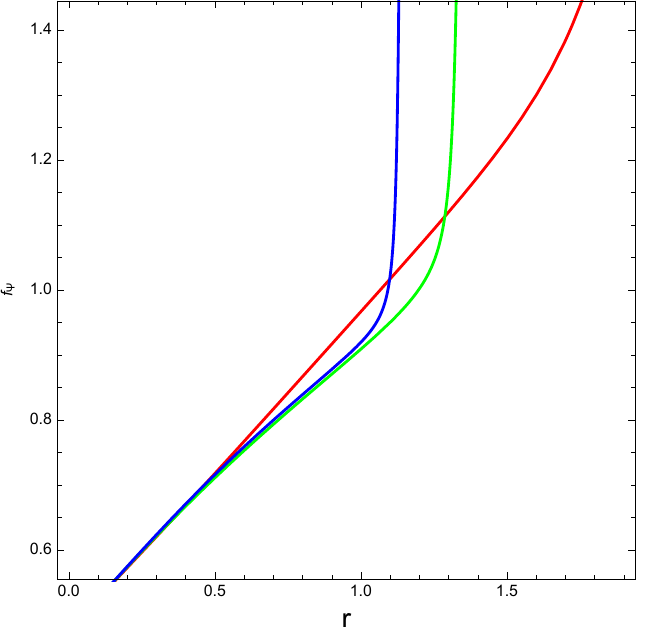
Figure 2. Solution of f ( R ( r )) for R adopted as a quadratic function of radius. The evolution of Equation (8) under f ( R ( r )) gravity is shown. We have fixed the values of a 0 , a 1 , a 2 , K , and C 1 . The red, green, and blue lines correspond to small perturbations of λ 0 , Ψ 0 , η 1 , η 2 , and η 3 ,